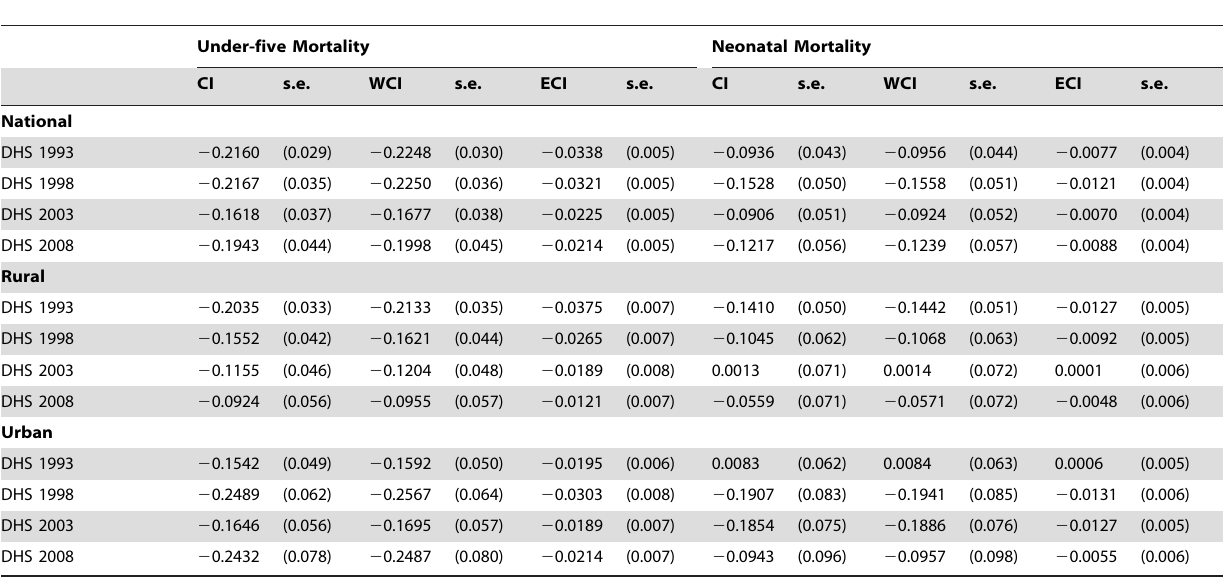
Table 1. Concentration indices of wealth-related inequalities in under-five and neonatal mortality, Philippines